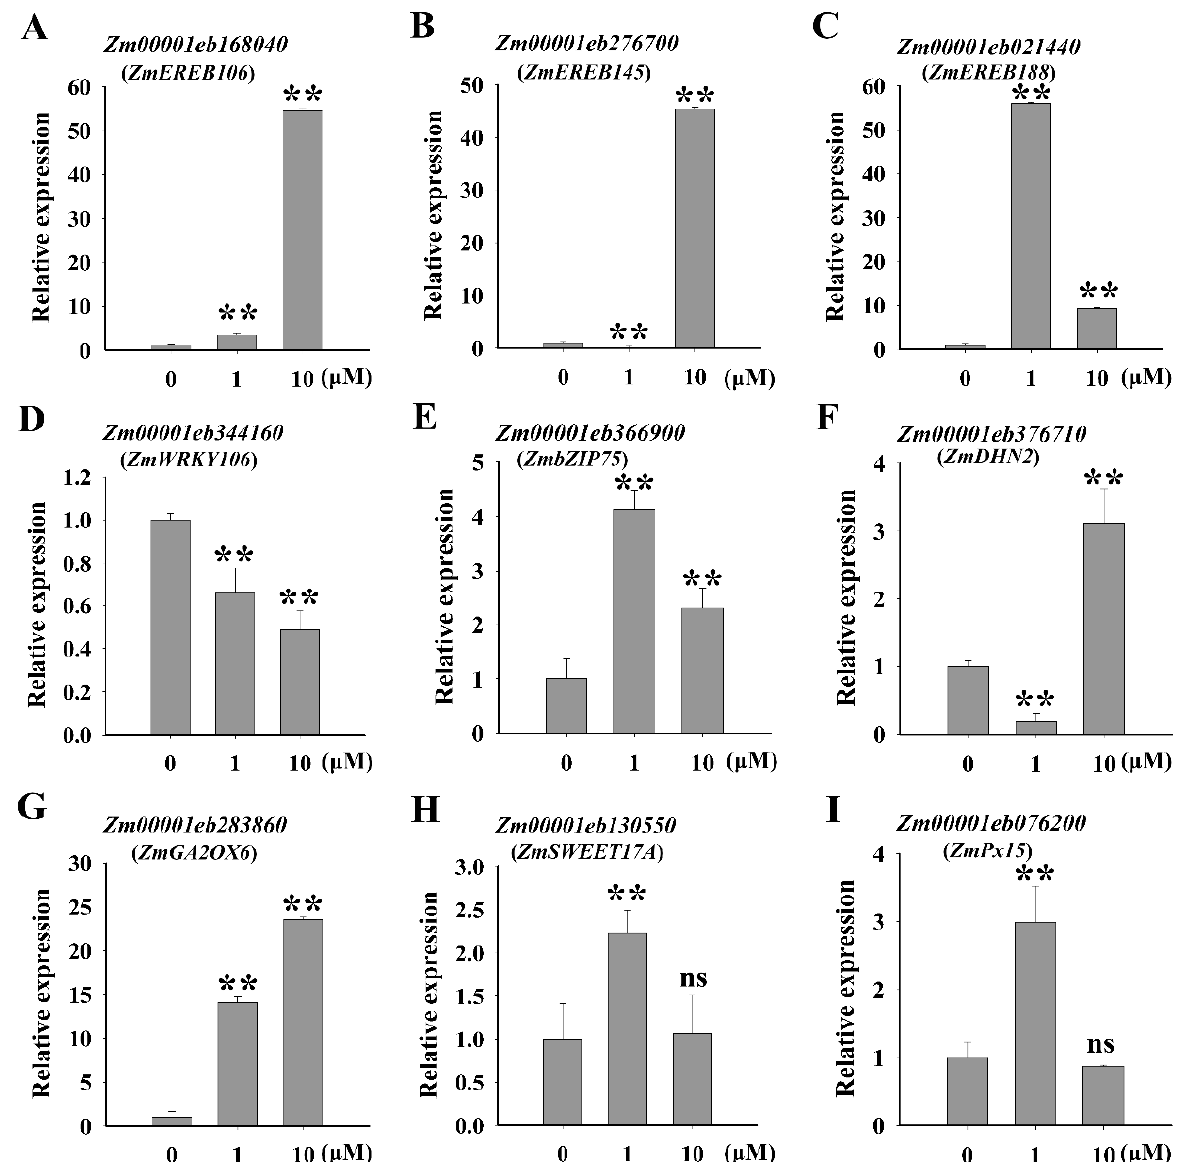
Figure 7. ( A – I ) Expression of genes involved in drought stress response by treatment with ABA. The wild-type B104 was treated with different concentrations of ABA for 1 h. SD values were calculated from three biological replicates. Asterisks indicate significant differences: ** p < 0.01 (Student’s t -test).